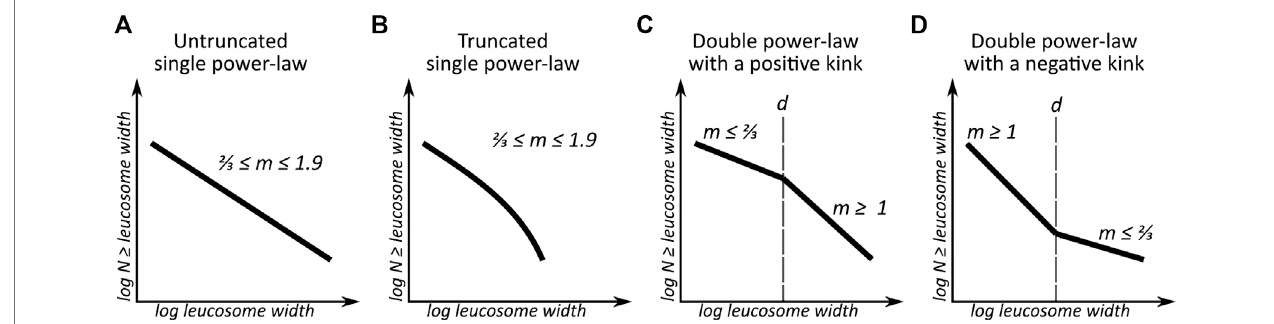
FIGURE1 | Simpli fi ed sketch ofthe different leucosomewidth distribution types. (A) In migmatites showing this leucosome distribution pattern, leucosomewidths follow a single untruncated power-law distribution. The value of m indicates the slope of the line: if m is above 1, most of the solidi fi ed melt resides in small leucosomes, butif m iscloseto2/3,thelargestleucosomesordikeshostthemajorityofthesolidi fi edmelt. (B) Theleucosomewidthsfollowasingletruncatedpower-law distribution, resultinginthecurvedshapeofthefunction.Truncationcanbeanartifactfrommeasuring,inwhichcaseitindicatesthatthemeasuredsectionwasnotlongenough to contain the largest leucosomes. Alternatively, truncation can result from the power-law distribution being limited, in which case it indicates that the largest measured leucosomes are nearly in the same order of magnitude as the largest possible leucosomes that follow this power-law distribution. (C) The smallest leucosomes follow a different power-law distribution from the largest leucosomes. The change from the fi rst trend to the second occurs at around width d . The leucosomes close to width d arerelativelymoreabundantthanin (A) . (D) Thesmallestandlargestleucosomesfollowdifferenttrends,butthesituationistheoppositeof (B) mostofthemeltisfoundin the very smallest and very largest leucosomes, while leucosomes sized around width d are underrepresented.